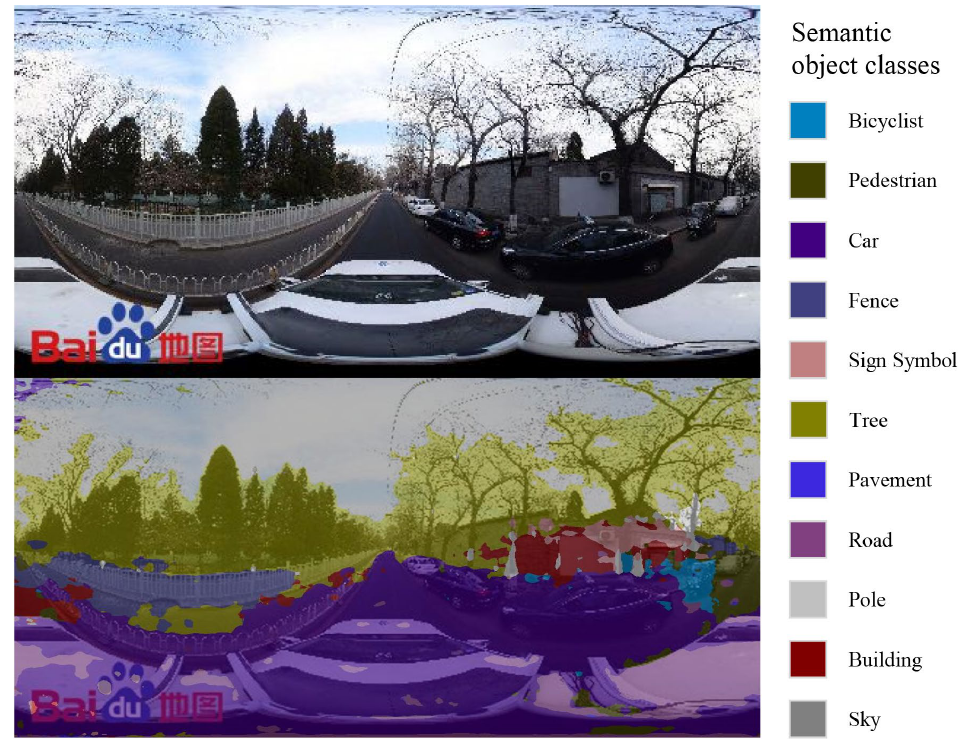
Figure 4. An example of semantic segmentation processing of Baidu street view imagery (The Chi- nese term ” 地图 ” means “map”).